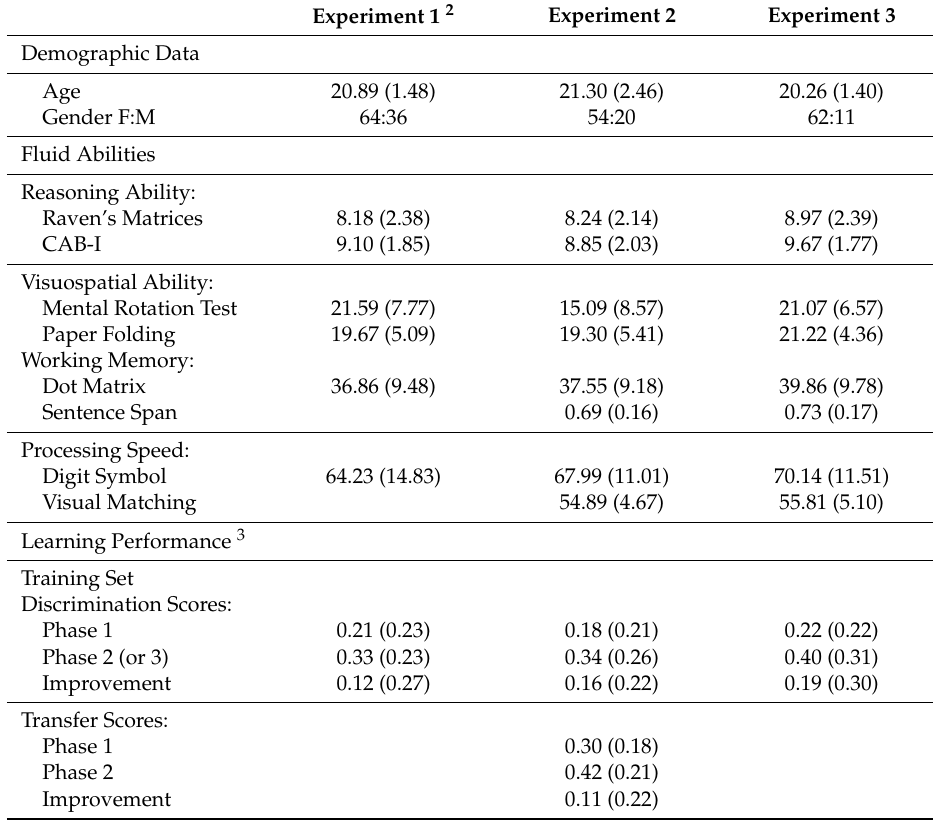
Table 2. Demographic and Behavioural Data 1